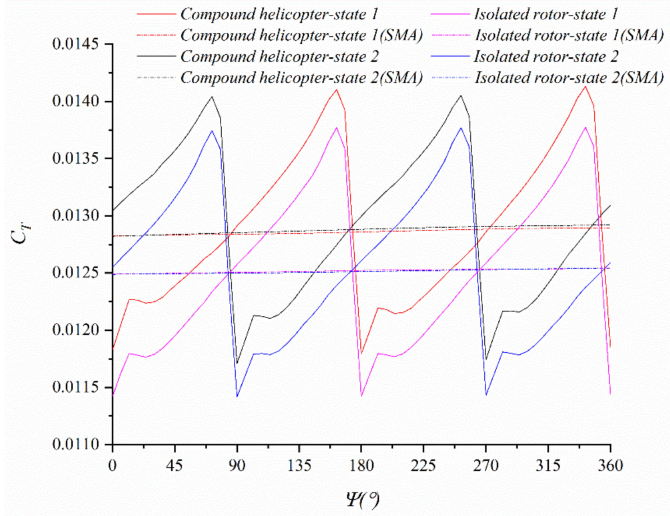
Figure 26. The compound coaxial helicopter rotor C T in